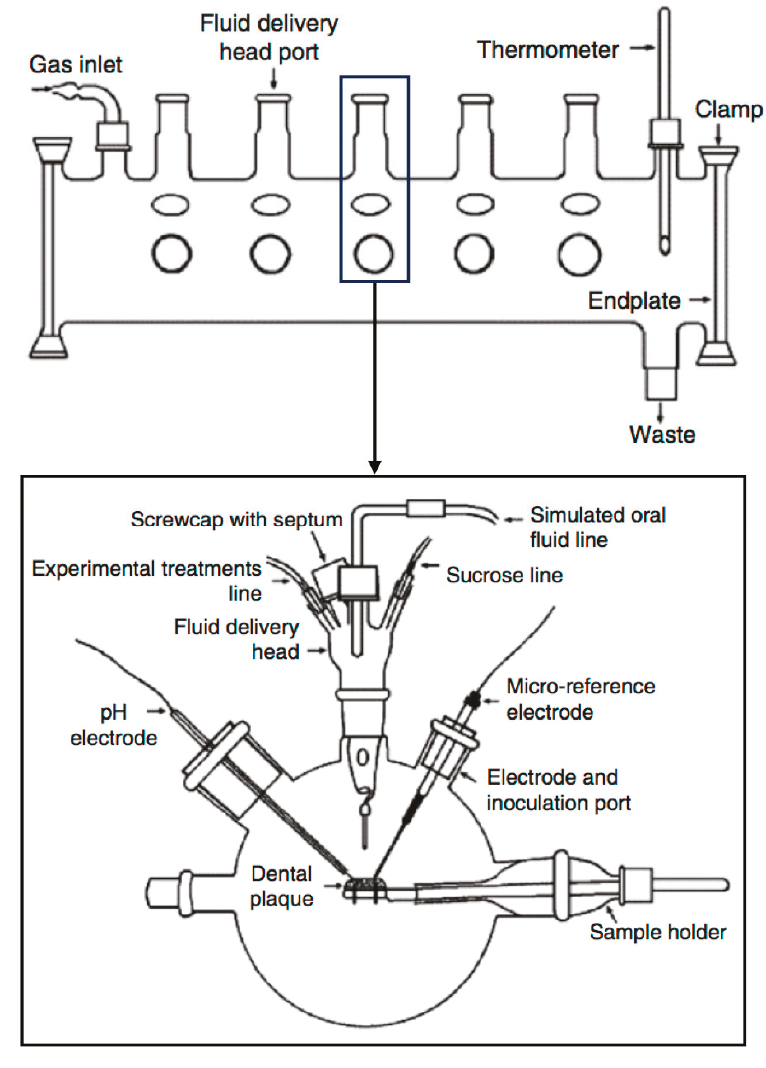
Figure 9. Schematic diagram of a multiple artificial mouth (adapted from Sissons et al., 2000 [47], with permission from © 2000 Springer. License number: